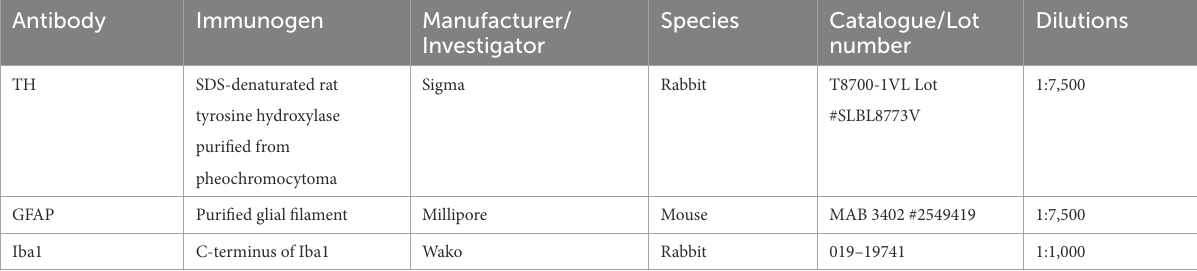
TABLE 1 Primary antibodies used for immunoperoxidase staining.